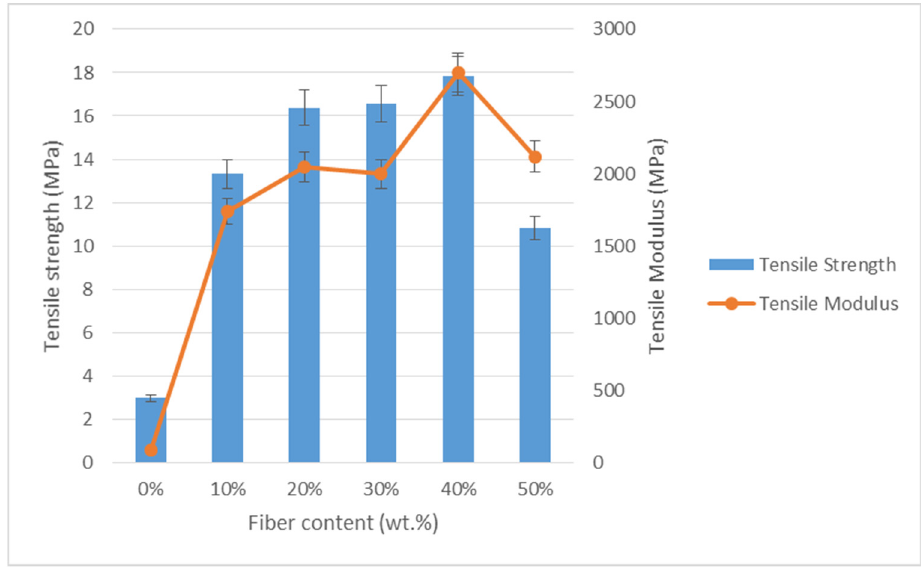
Figure 4. Tensile strength and modulus of TPCS/BLF composites. Table 1. ANOVA of tensile properties.